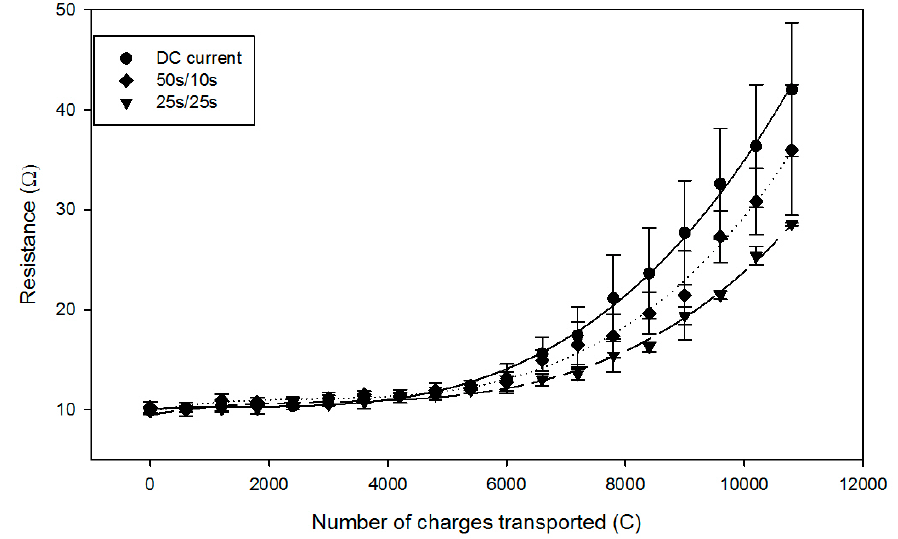
Figure 4. Global system resistance evolution for DC (dots), PEF 50 s/10 s (rhombuses), and PEF 25 s/25 s (inverted triangles) current conditions.